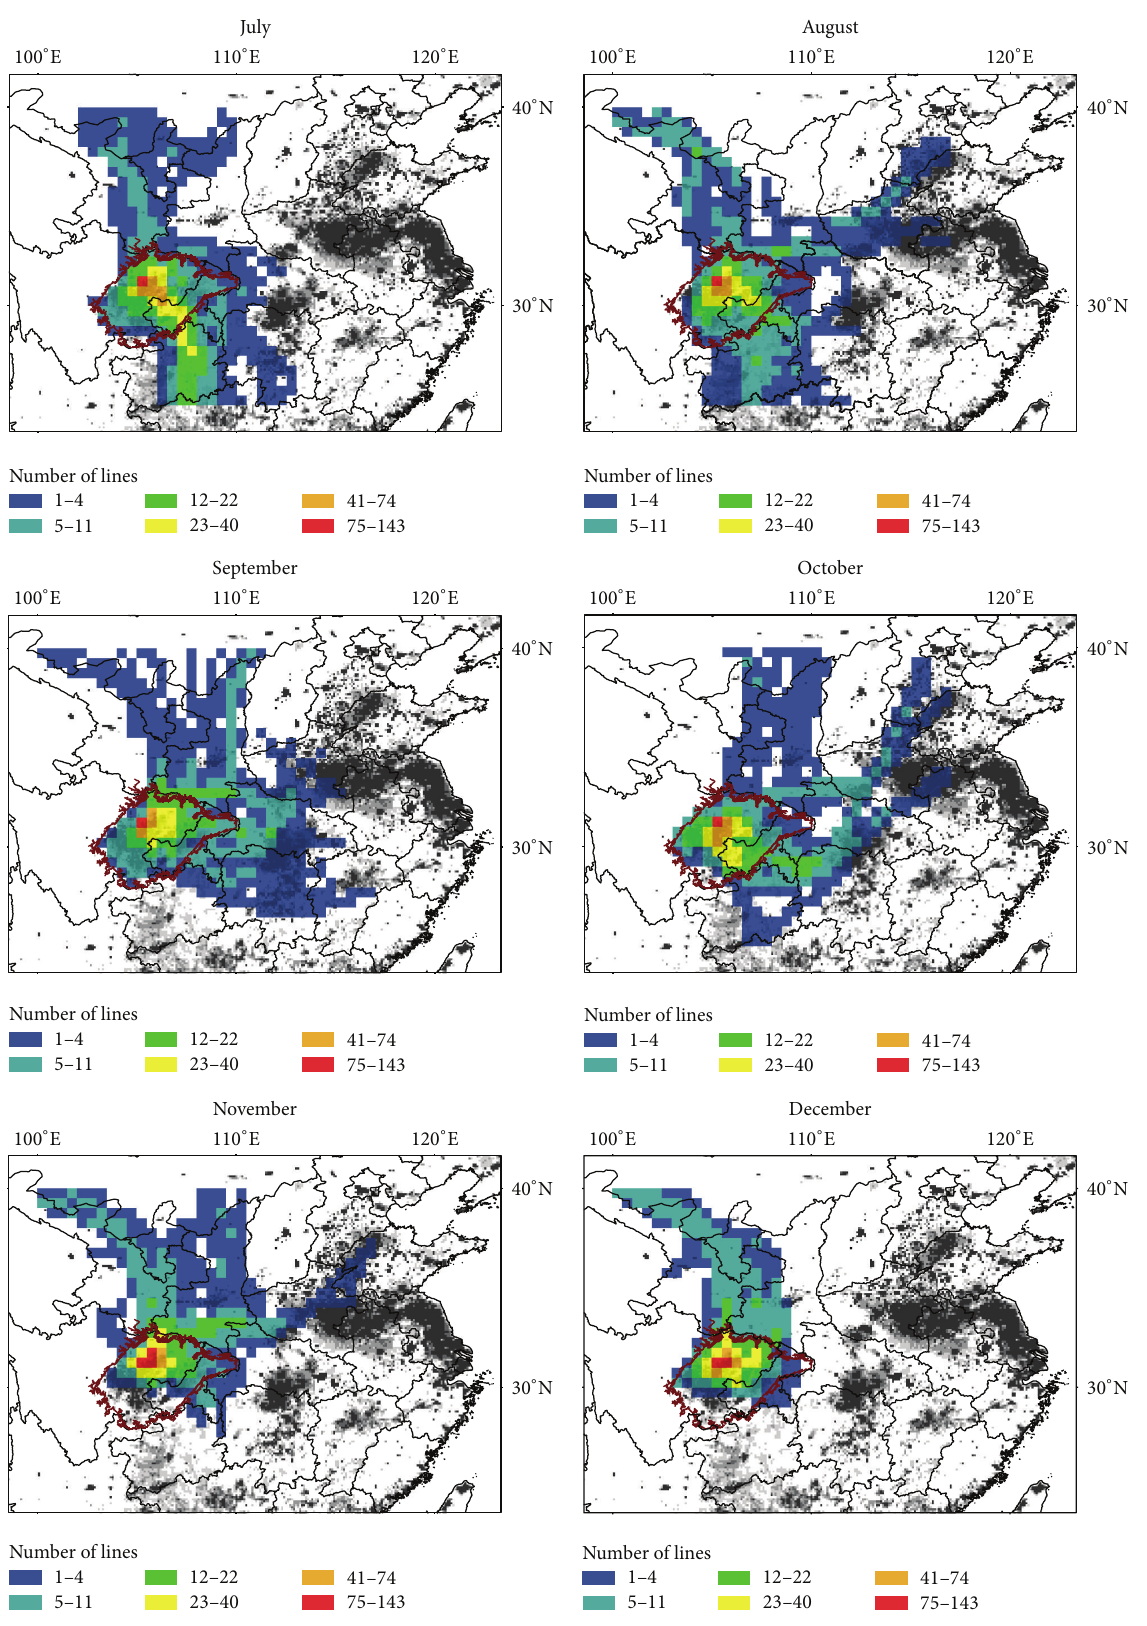
Figure 6: The density of the backward simulated trajectories, which are gridded into 0.5 by 0.5 degree grids, from Yanting in the Sichuan Basin for each month in